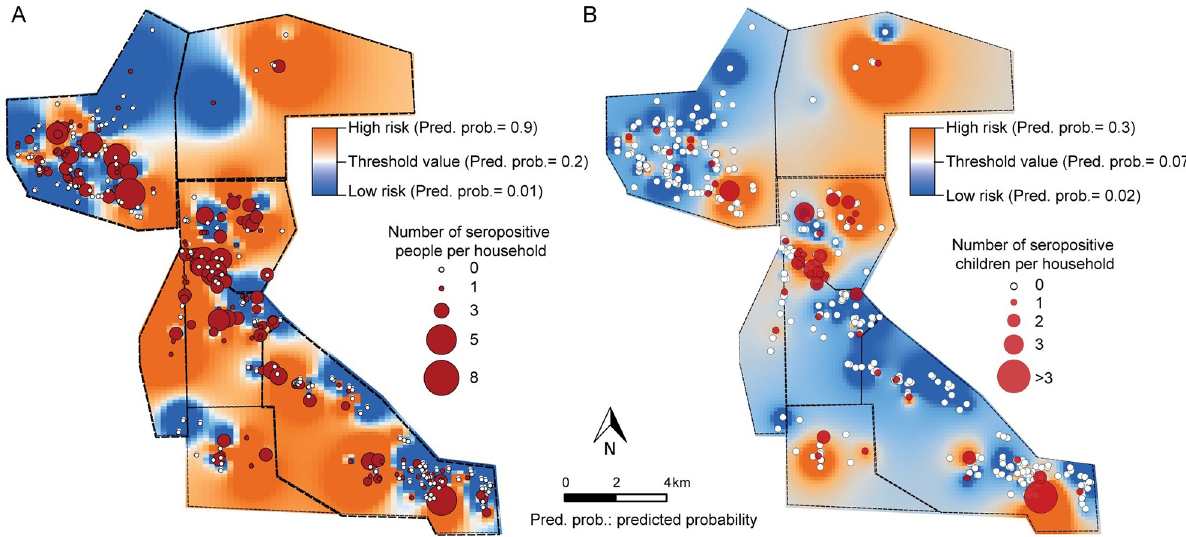
Fig 6. Risk maps of T . cruzi human infection for the total population (A) and children (B) in 2008, prior to a community-wide insecticide spraying campaign, Pampa del Indio, Argentina. The maps were created in QGIS 2.18.11. based on the data collected within the scope of this study (S4